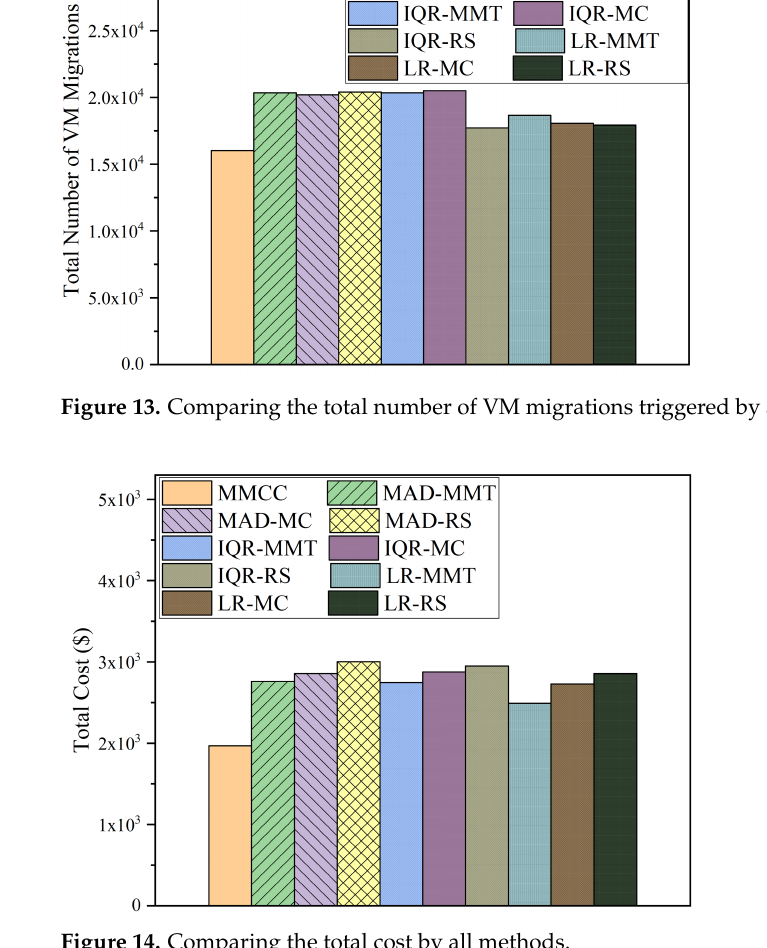
Figure 14. Comparing the total cost by all